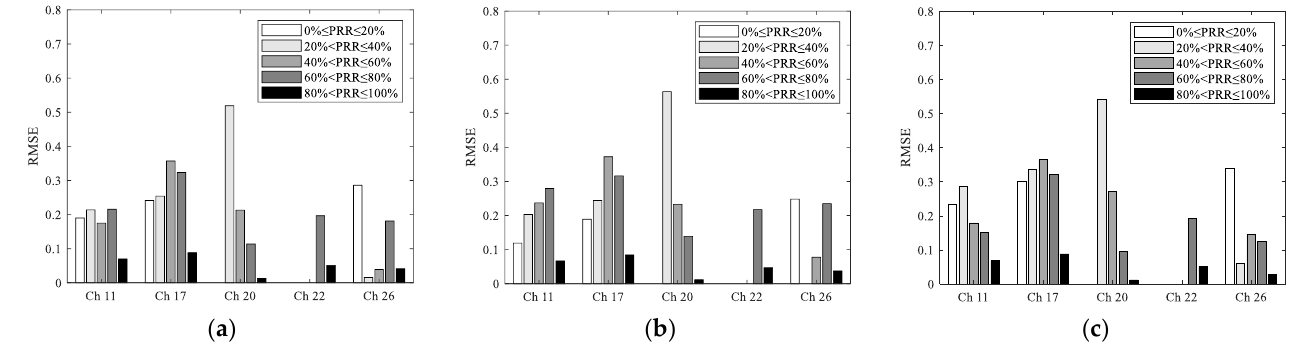
Figure 12. RMSEs of the CU-LQI model, LR-LQI model, and ML-LQI model under different channels: ( a ) RMSE of the CU-LQI model for different PRR ranges; ( b ) RMSE of the LR-LQI model for different PRR ranges; ( c ) RMSE of the ML-LQI model for different PRR ranges.